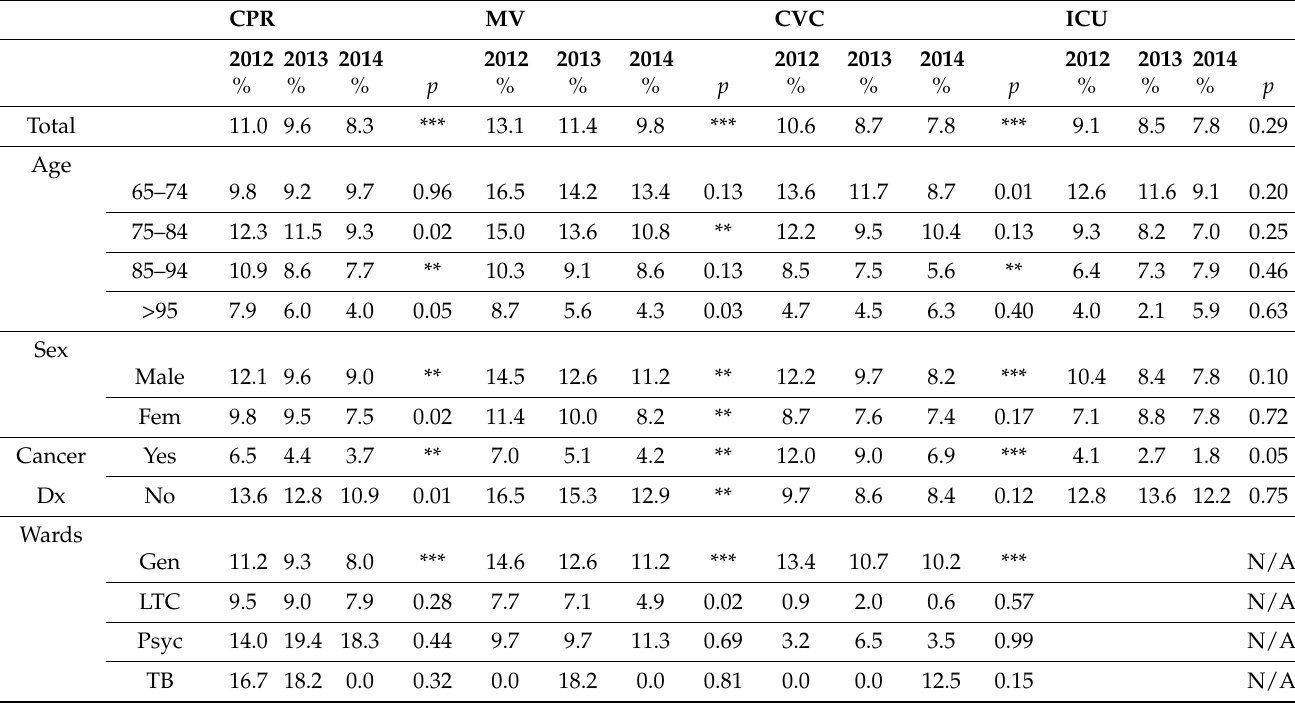
Table 2. Annual trends in the administration of life-sustaining treatments and intensive care unit admissions in the last 7 days of life from 2012 to 2014.